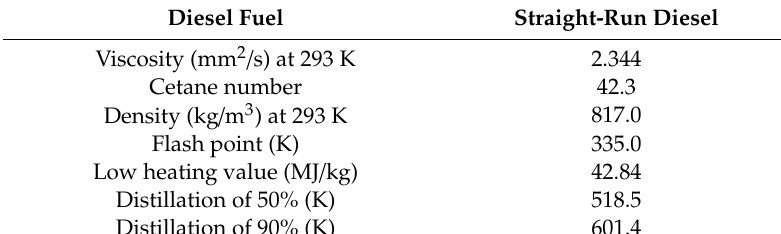
Table 1. Fuel properties of the diesel fuel in the experiment.